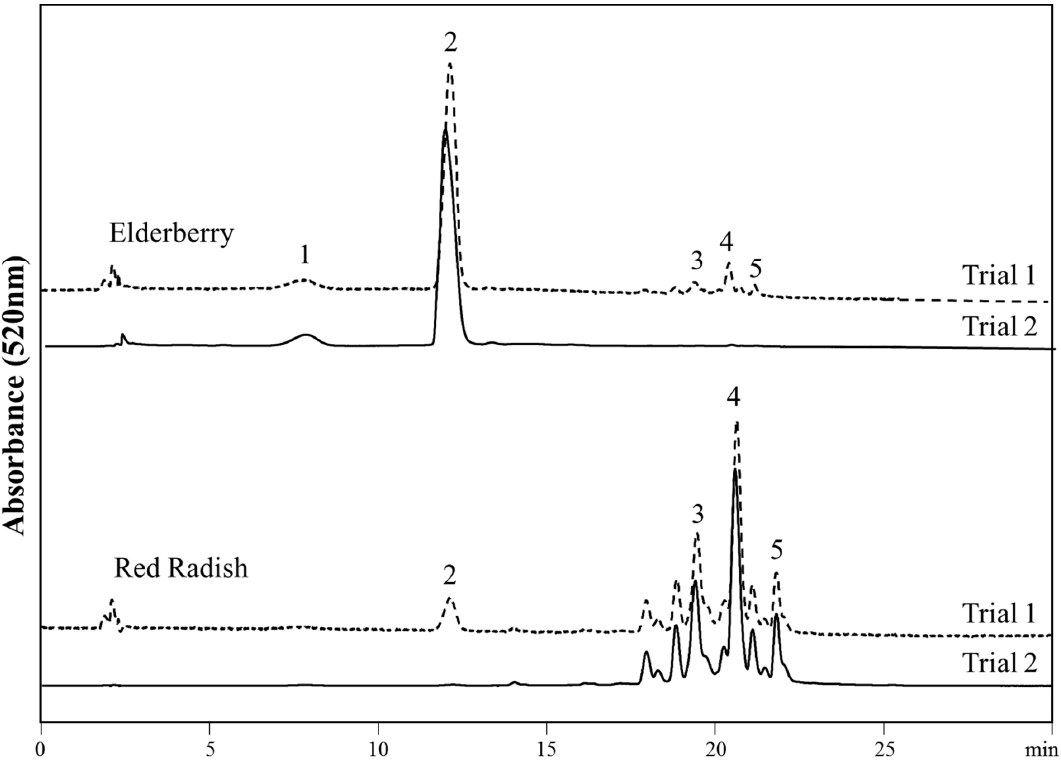
Figure 1. High-performance liquid chromatography (HPLC) chromatograms at 520 nm obtained from skin samples treated with ACN-lipstick formulations. Trial 1 chromatograms correspond to samples collected using an alternating pattern of lipstick formulations on the skin. Trial 2 chromatograms correspond to samples collected using a non-alternating pattern. Numbers correspond to peak identification shown in Table 1.